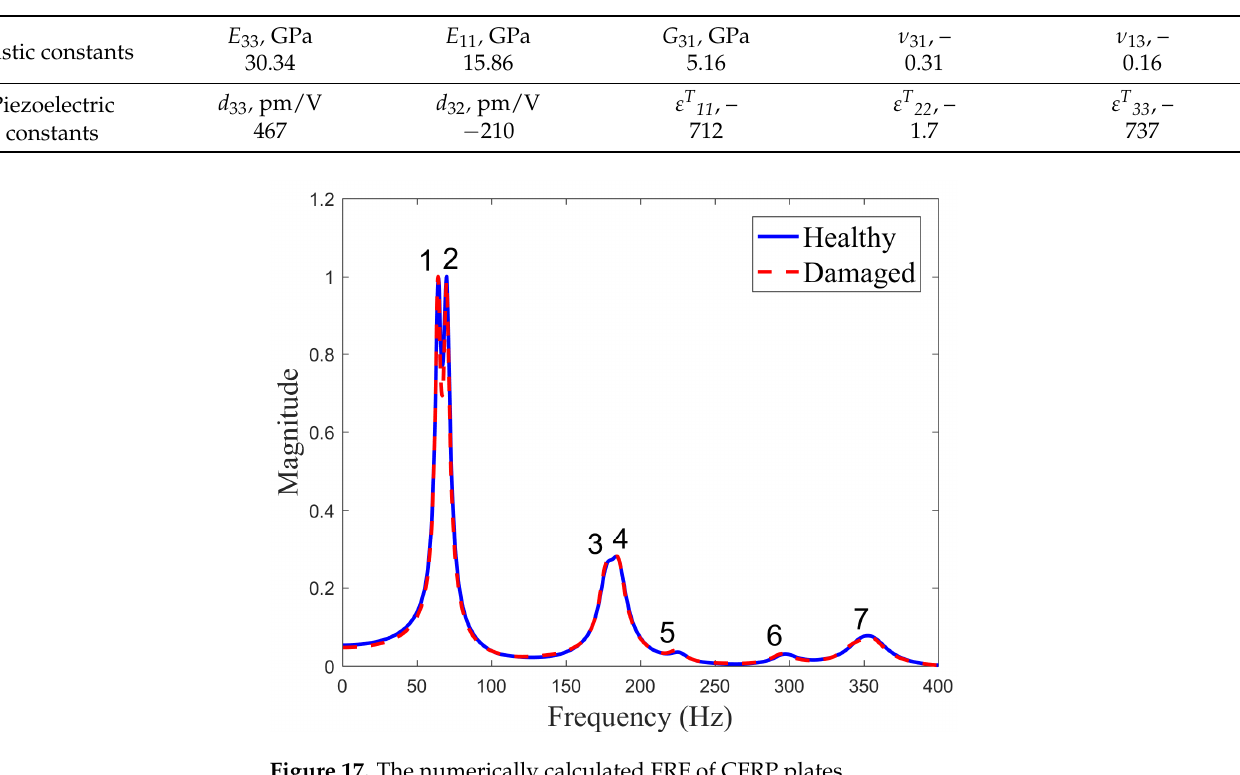
Table 5. MFC material properties provided by Smart Materials [36].